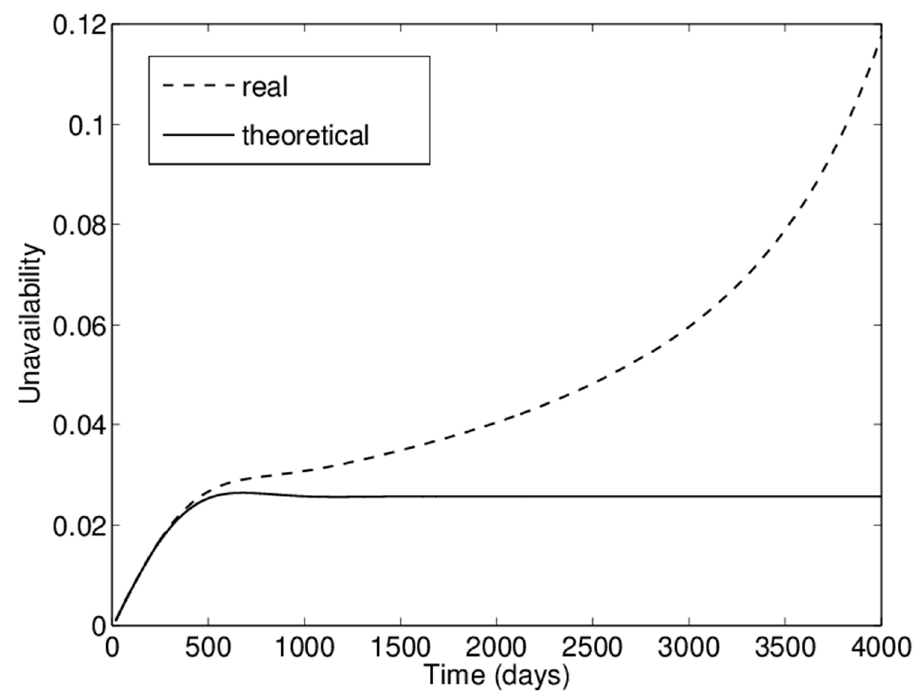
Figure 4. Theoretical versus real ( q a = 1.25) ageing of one-component system discussed.